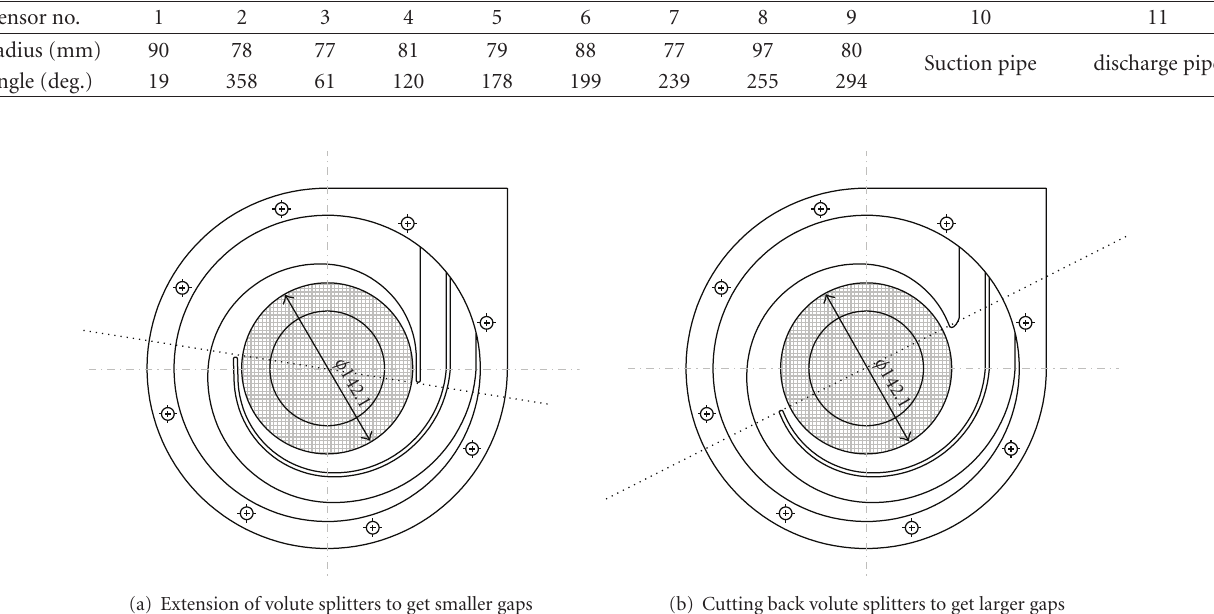
Figure 5: Schematic for gap modifications.